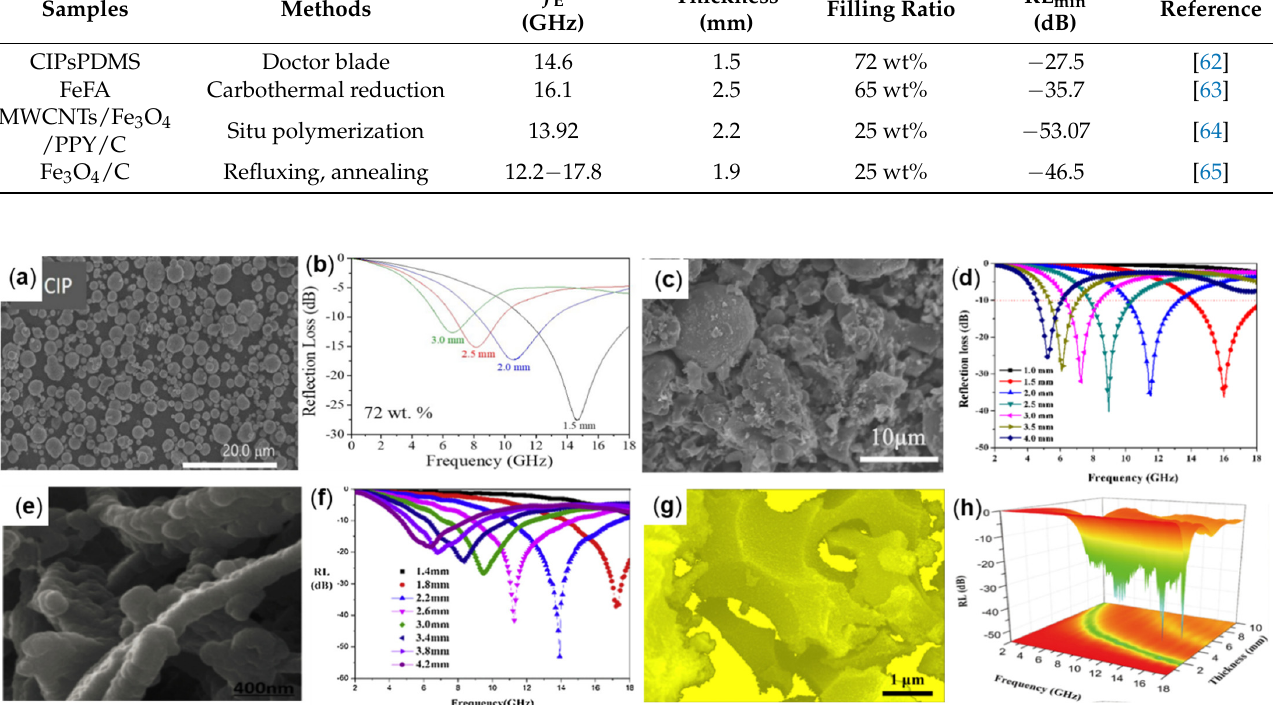
Figure 8. ( a ) SEM and ( b ) RL plot of CIPsPDMS, reproduced with permission from Ref. [62], Copyright 2020, New Physics Sae Mulli. ( c ) SEM and ( d ) RL plot of FeFA, reproduced with permission from Ref. [63], Copyright 2020, American Chemical Society. ( e ) SEM and ( f ) RL plot of MWCNTs/Fe 3 O 4 /PPY/C, reproduced with permission from Ref. [64], Copyright 2020, Elsevier. ( g ) SEM and ( h ) RL plot of Fe 3 O 4 /C, reprinted with permission from Ref. [65], Copyright 2019, Elsevier.